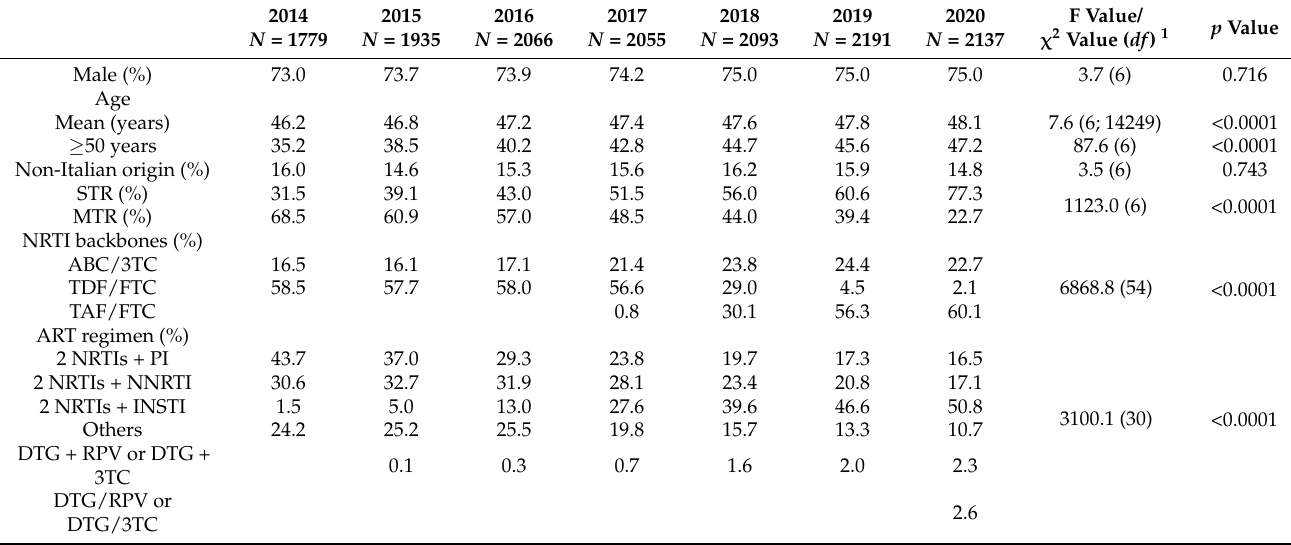
Table 2. Characteristics for treatment-experienced patients during